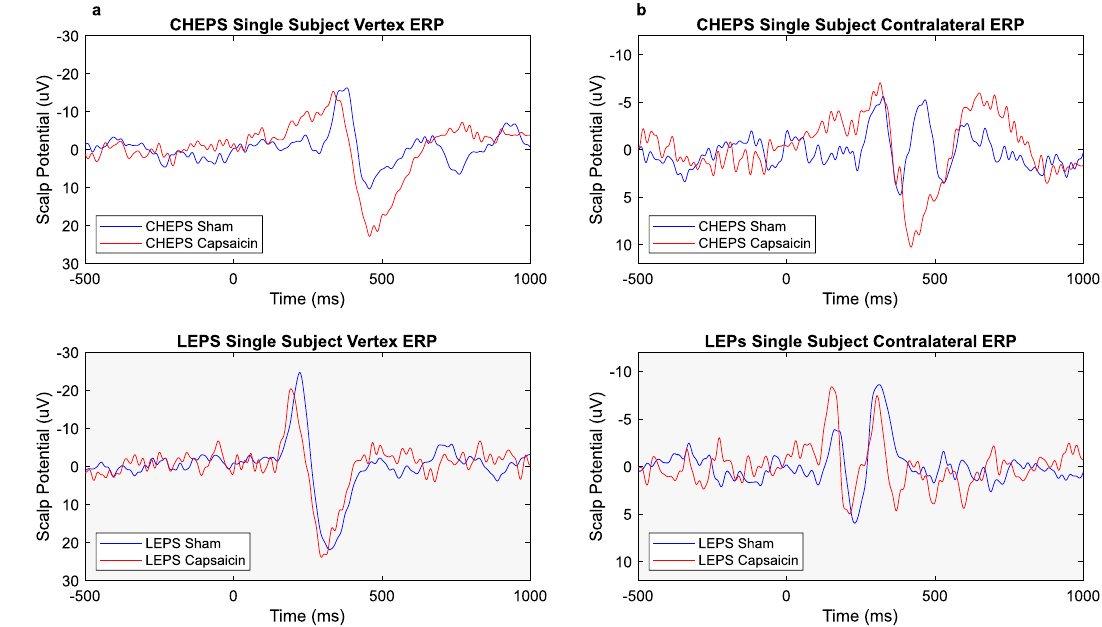
Figure 6. CHEPs and LEPs Single Subject Average. Illustrated are the average potentials measured at (column a ) the vertex (N2P2 waveform) and (column b ) contralateral electrodes C3 (N1 waveform) of subject C14. CHEPs are indicated with a white background and LEPs with a grey background. The blue lines illustrate the grand average of the sham condition and the red line the grand average of the capsaicin